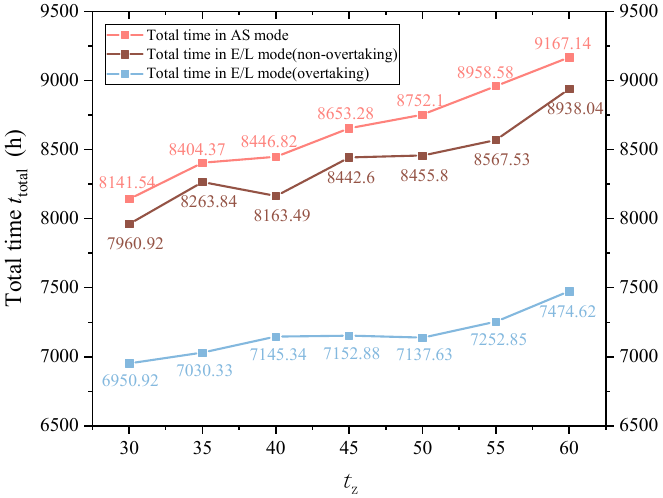
Figure 10. Comparison of different t z values.